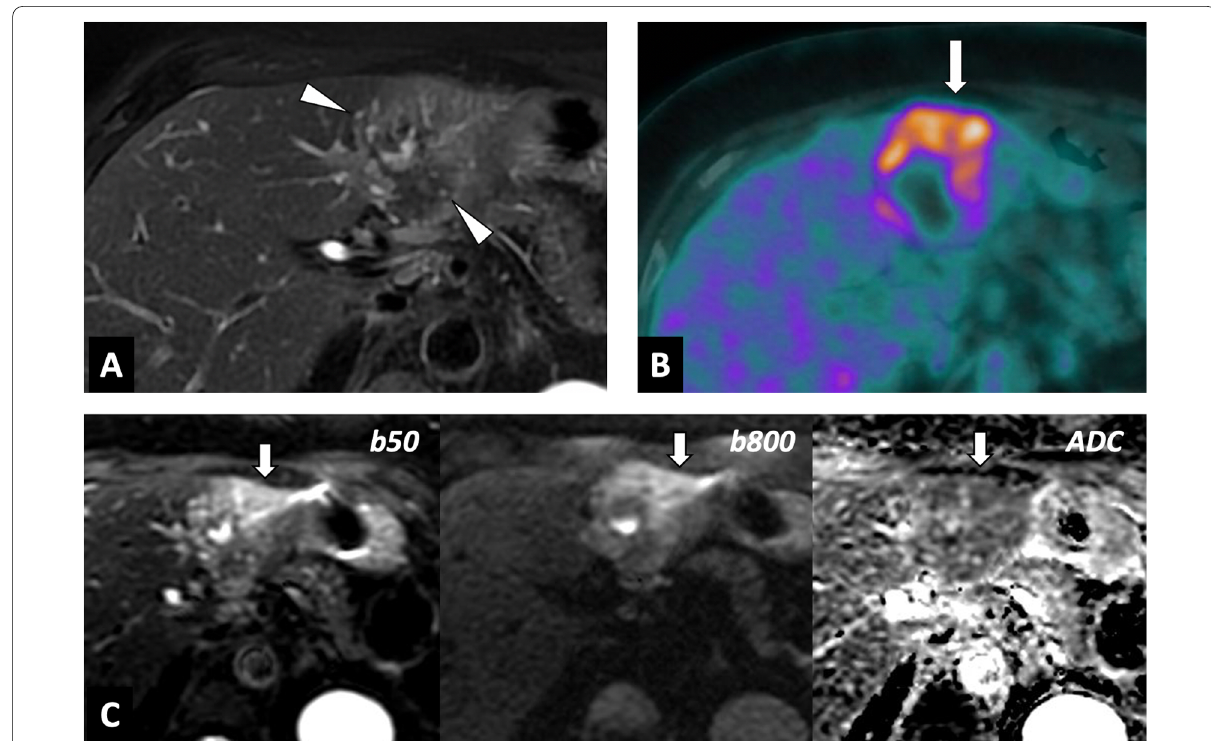
Fig. 9 Alveolar echinococcosis lesion of the left liver lobe in 56‑year‑old woman. Assessment of parasitic activity on MRI and FDG‑PET/CT scan. A T2‑weighted MR image in the axial plane. AE lesion in mixed T2 hypo‑ and hypersignal, with peripheral microcysts (arrowheads). B Diffusion‑weighted imaging showing peripheral hypersignal of AE lesion. C Correlation with FDG‑PET/CT scan. Increased FDG‑uptake at the periphery of the